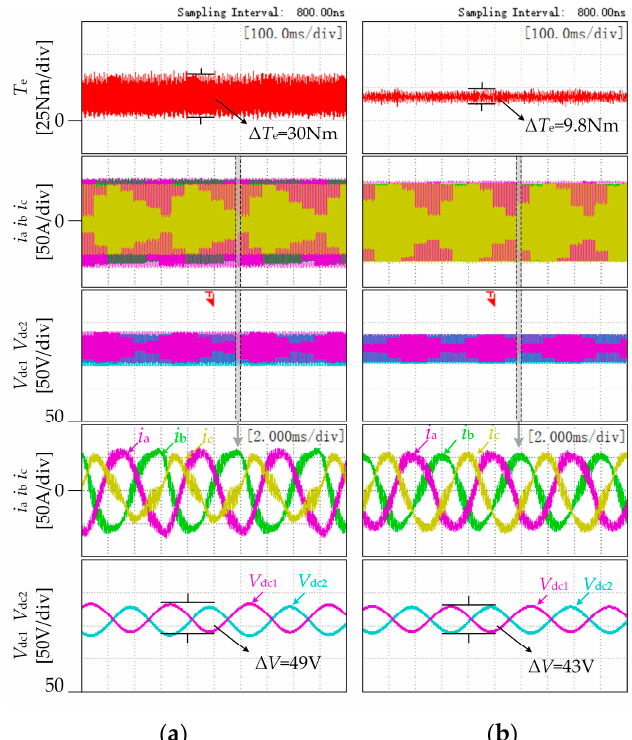
Figure 6. Experimental results at 2500 r/min and 20 Nm: ( a ) without capacitor voltage offset suppression; ( b ) proposed method.